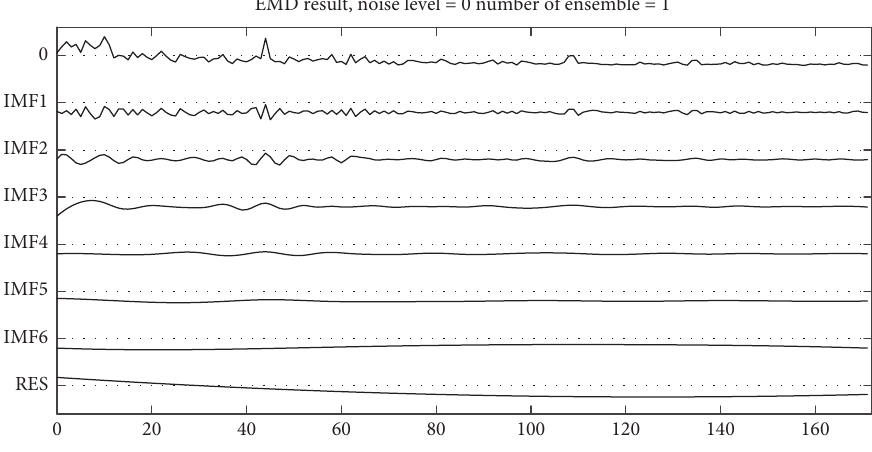
Figure 3: Mining safety accidents time series decomposition map by the EMD